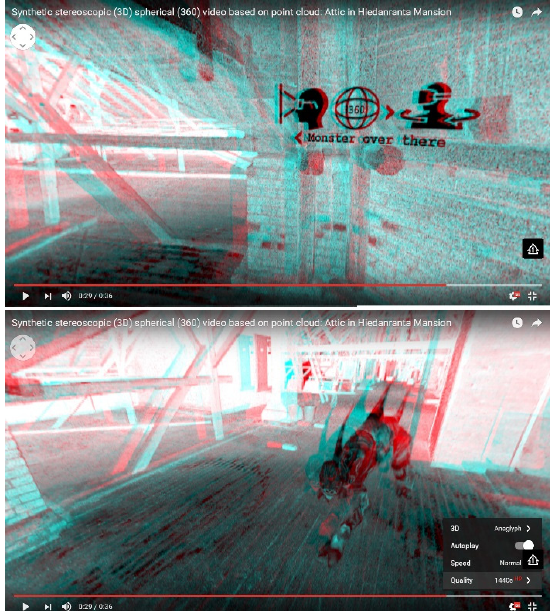
Figure 8. Animation based on sythethis stereoscopical spherical images, Lielahti ’s attic, Tampere